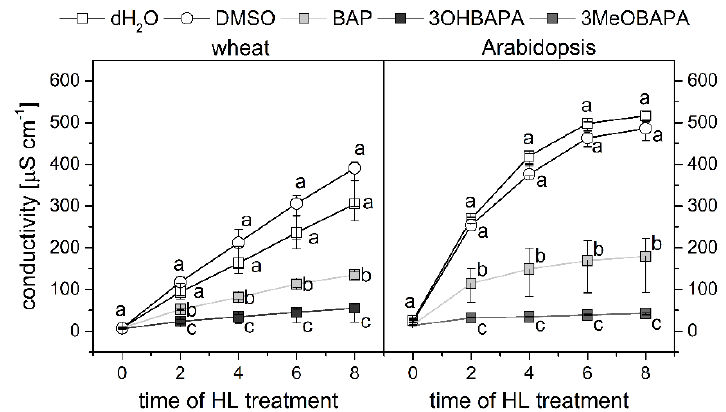
Figure 7. Conductivity as a measure of cell membrane damage in wheat- and Arabidopsis-detached leaves incubated in deionized water (dH 2 O), 0.1% DMSO, 10-µmol·L − 1 solutions of BAP, 3OHBAPA or 3MeOBAPA. Before high-light treatment (HL; 500 µmol photons·m − 2 ·s − 1 ) for up to 8 h leaves were incubated in the dark for 6 days. Medians and quartiles are presented ( n = 7). Different letters indicate a statistically significant difference between treatments within a plant species and particular time point ( p < 0.05; Student’s unpaired t -test).